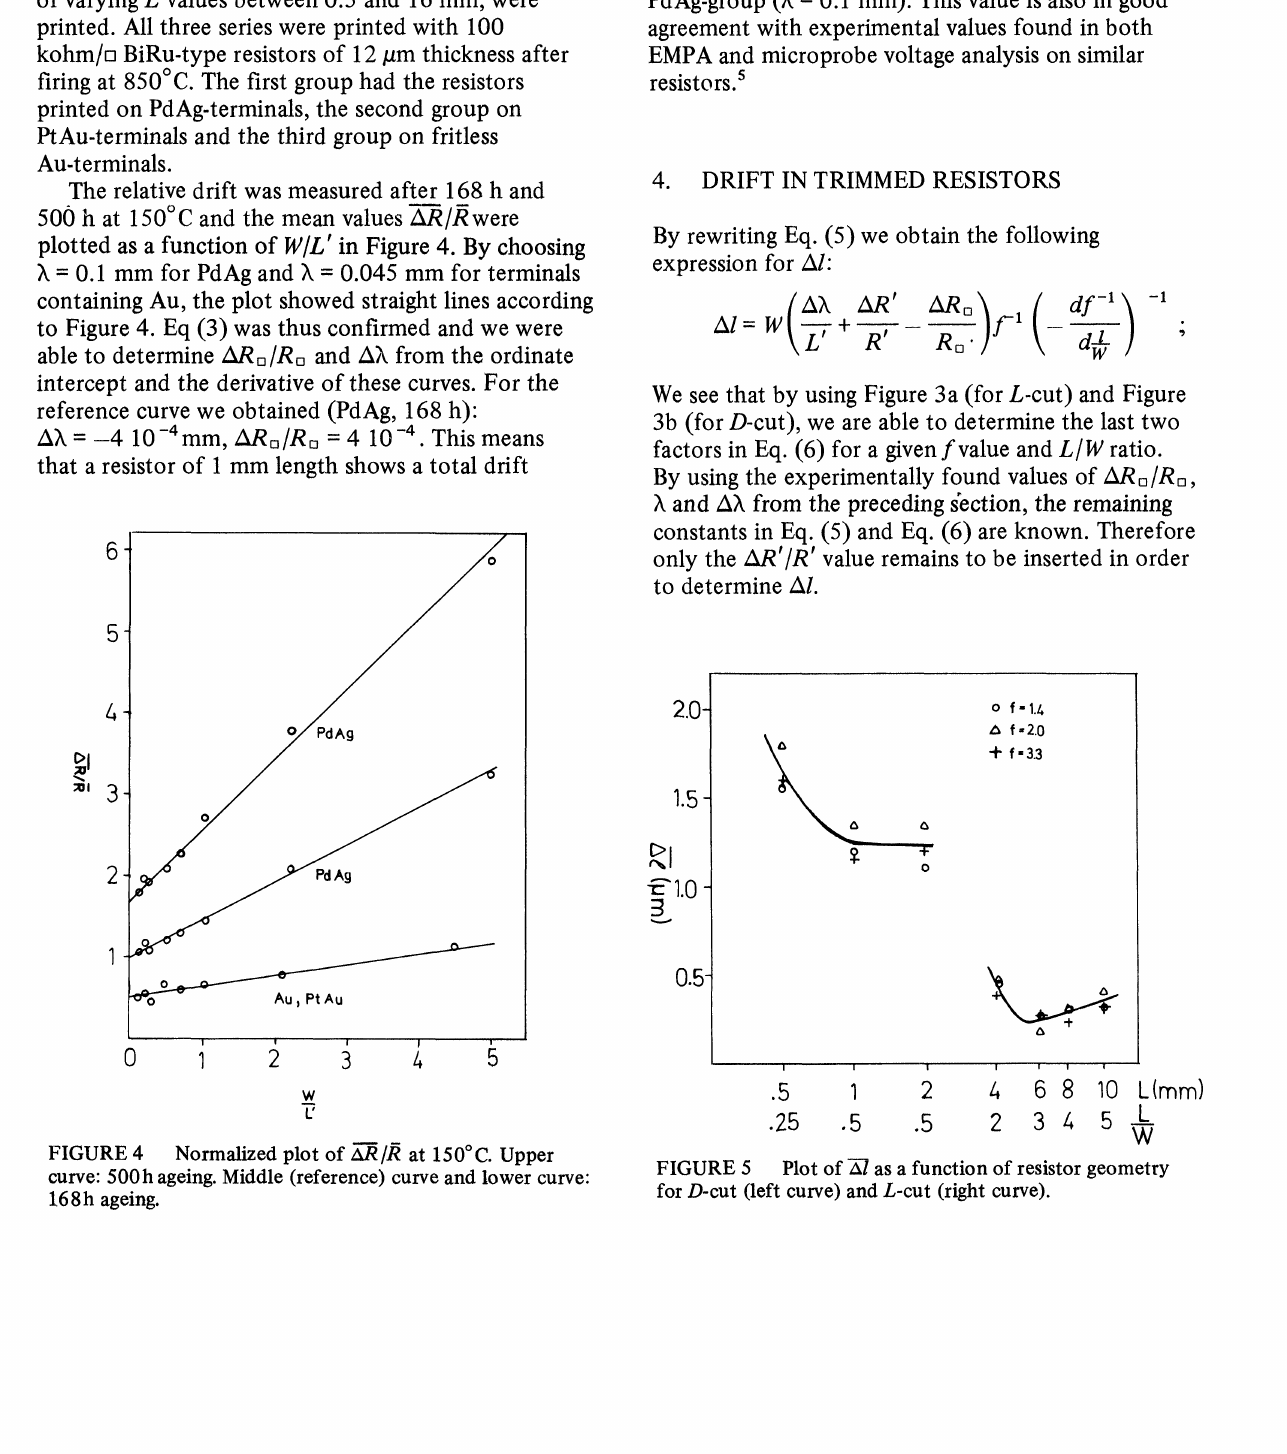
Plot of as a function of resistor geometry for D-cut (left curve) and L-cut (right